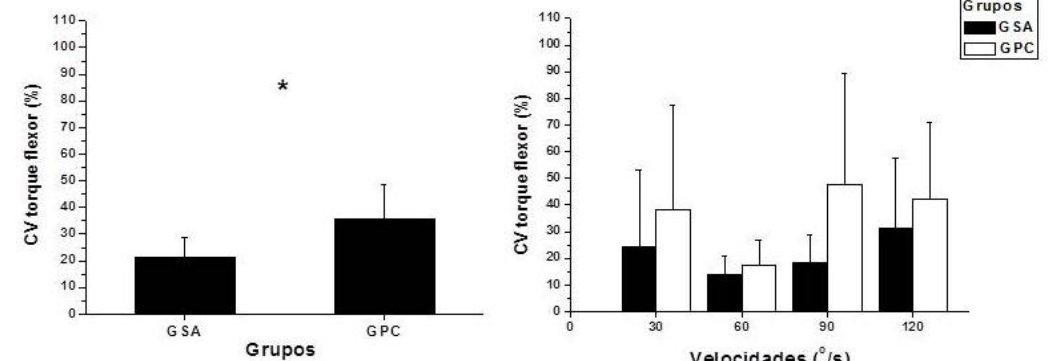
Figura 8. Média e desvio padrão do coeficiente de variação do torque flexor nos grupos GSA e GPC e média e desvio padrão do coeficiente de variação do torque nas velocidades 30, 60, 90 e 120°/s. * diferença estatisticamente significante entre